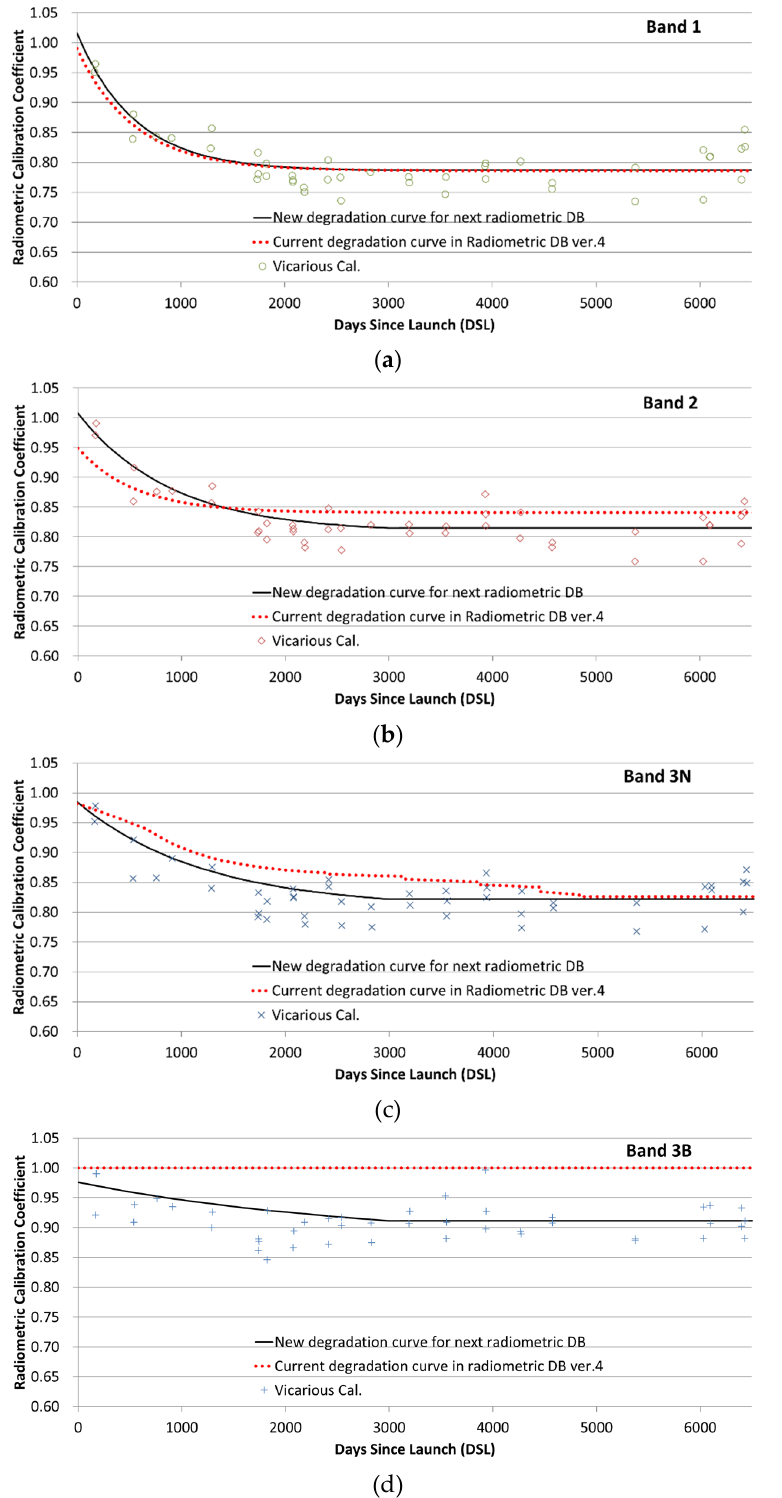
Figure 4. New degradation curves of ASTER VNIR bands for the next radiometric DB ver. 5. Bands ( a ) 1, ( b ) 2, ( c ) 3N, and ( d ) 3B. Solid lines correspond to the new degradation curves for the next radiometric DB estimated from the vicarious calibration data from 2000 to 2017 with the lunar calibration on April 14, 2003 (DSL = 1213), and August 5, 2017 (DSL = 6440). Dotted lines correspond to the current degradation curves in the current radiometric DB ver. 4. The marks show the RCCs from the vicarious calibration.